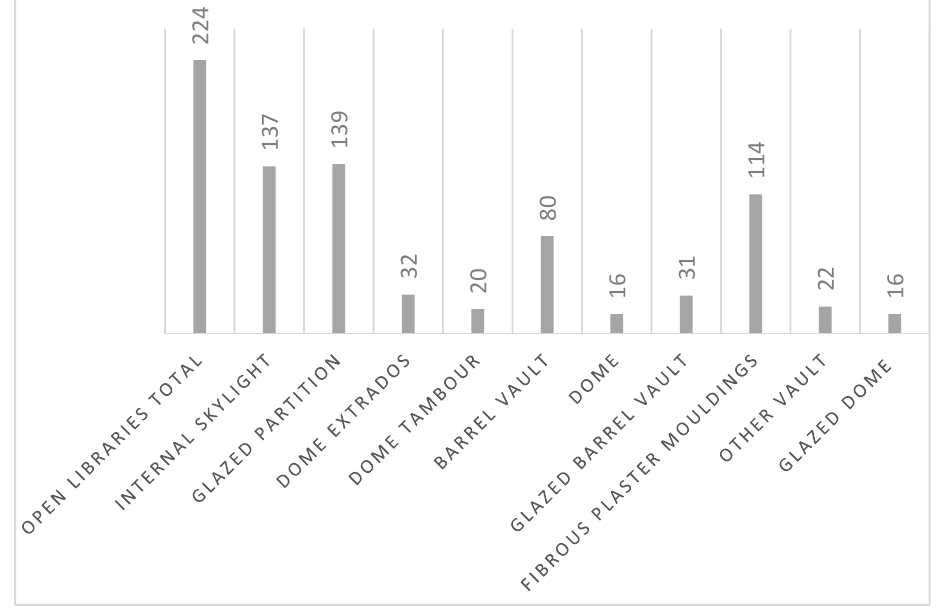
Table 2. Incidences of Internal Features across all open UK Carnegie Library buildings. Source: